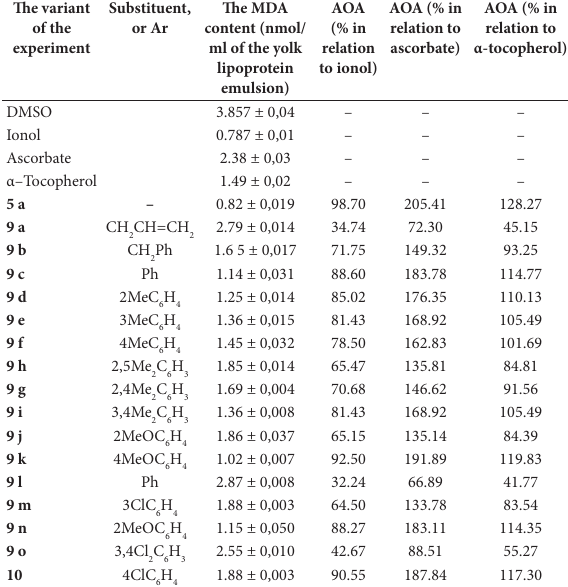
Table 1. The antioxidant activity of derivatives containing the 5,6,7,8-tetrahydro-2,2a,8-triazacyclopenta[ cd ]azulene moiety (in % of inhibition of the formation of TBA-reactive products). The variant of